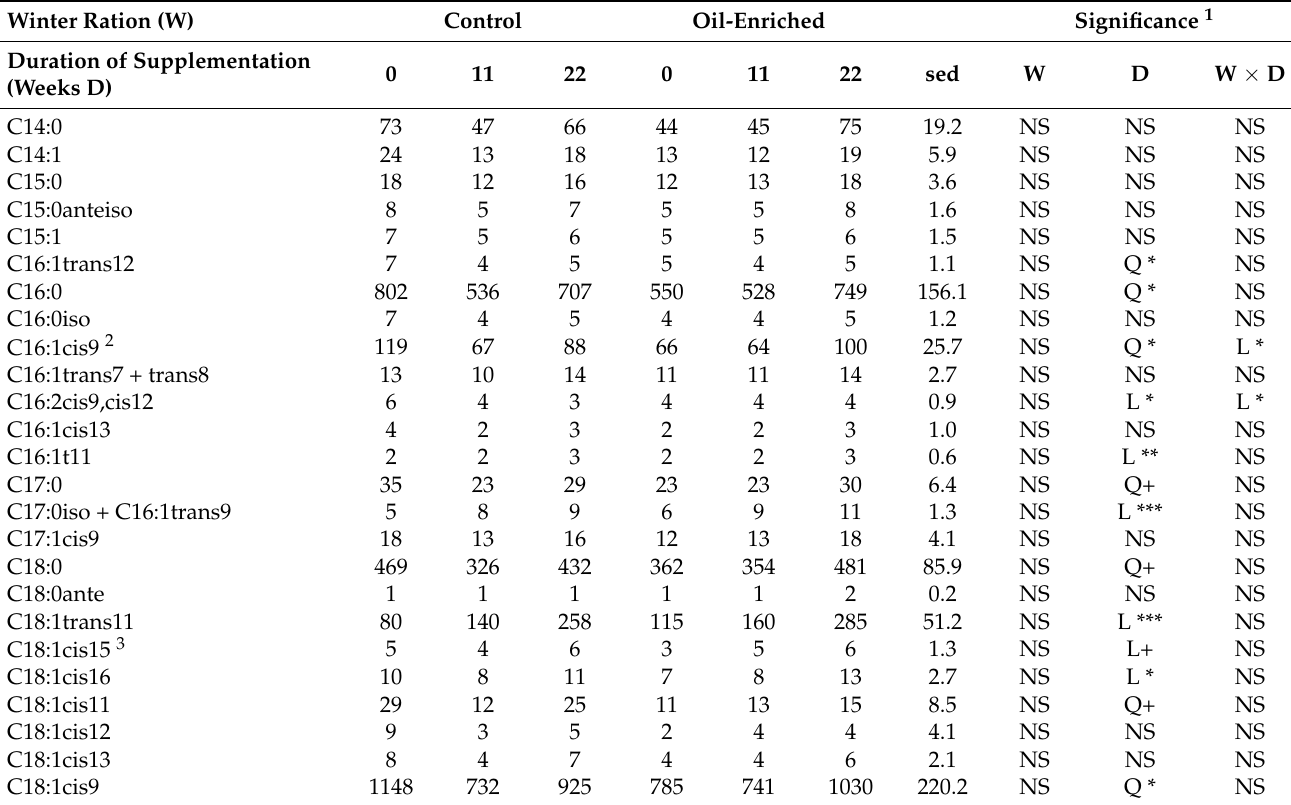
Table 3. The concentration of fatty acids (mg/100 g muscle) in longissimus muscle of beef heifers. Control Oil-Enriched Significance